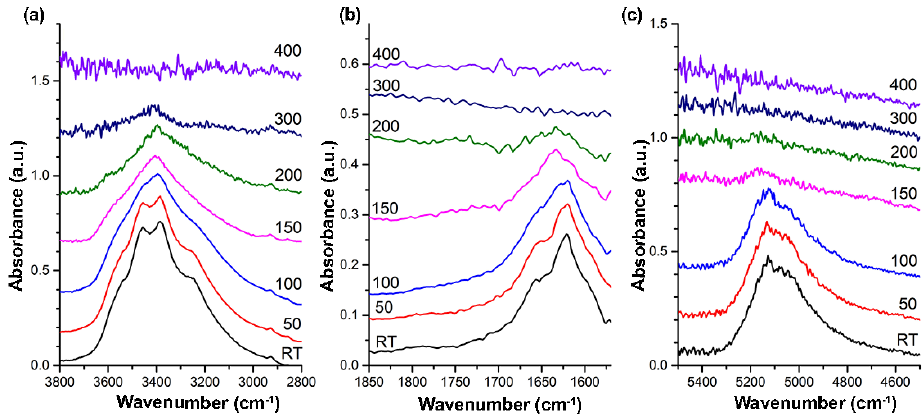
Figure 5. In situ HT-FTIR spectra collected on ( a , b ) KBr pellet and ( c ) pressed melanterite powders. ( a ) OH/H 2 O stretching region, ( b ) OH/H 2 O bending region, ( c ) H 2 O ( ν 3 + ν 1 ) combination mode. Temperature, °C, is indicated on each pattern.